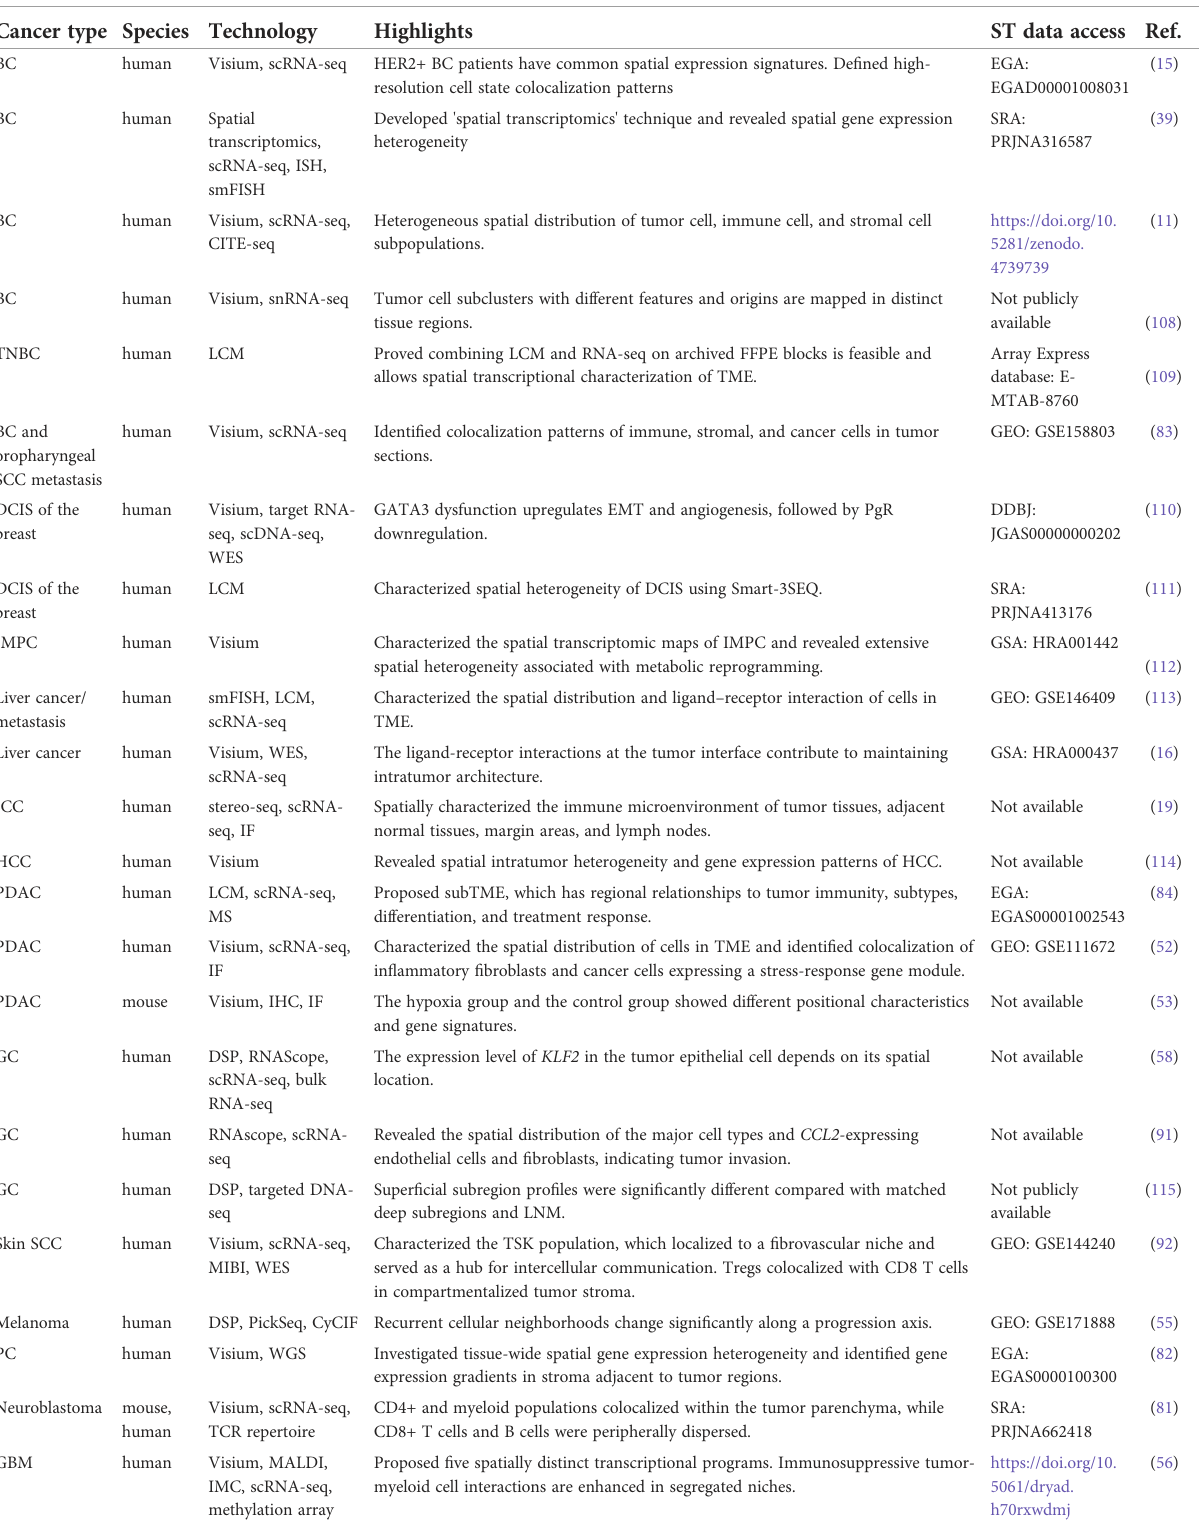
TABLE 2 ST-based cancer studies. Spatial heterogeneity Cancer type Species